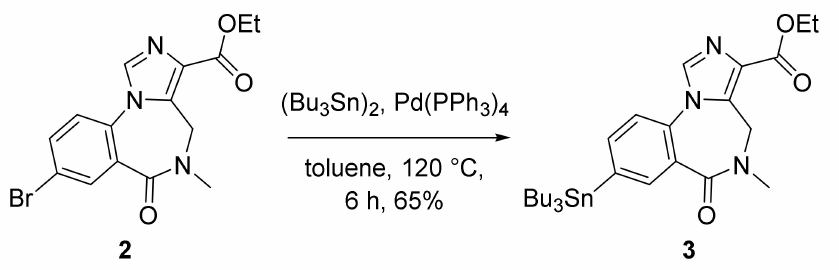
Figure 2. Synthesis of stannyl precursor 3 .